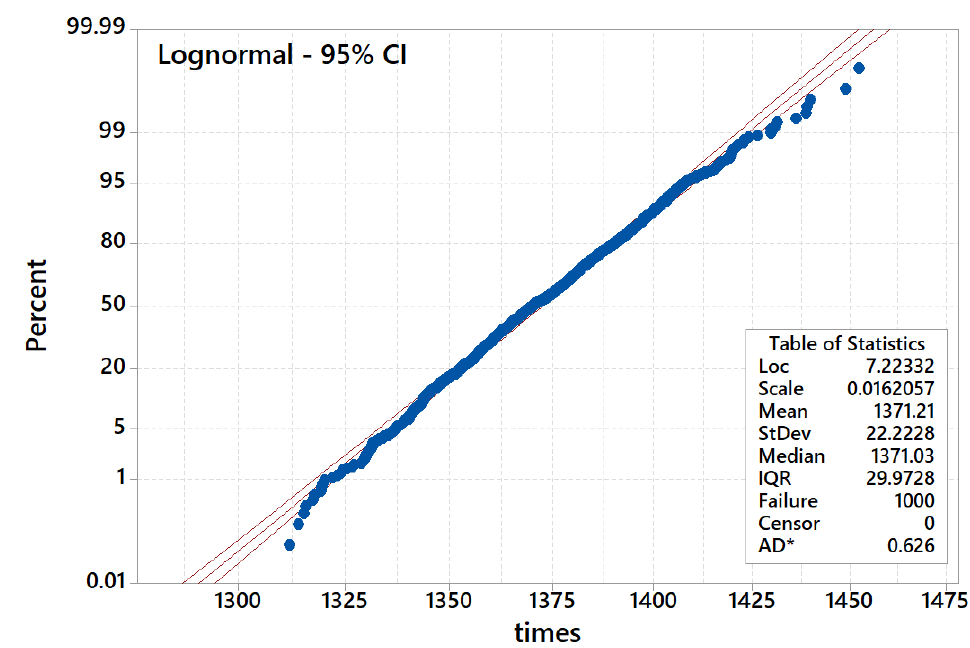
Figure 7. Fitting the makespan observations obtained via simulation by a log-normal distribution.